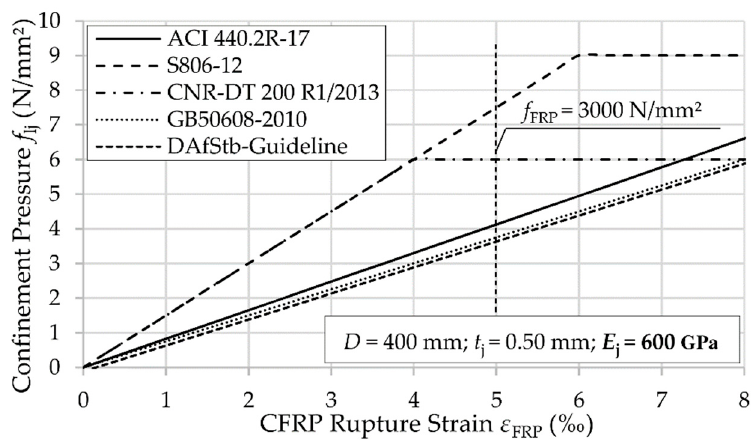
Figure 4. Confinement pressure f lj depicted as a function of CFRP rupture strain ε FRP (derived from flat coupon tests) when the modulus of the composite material is E j = 200 GPa.